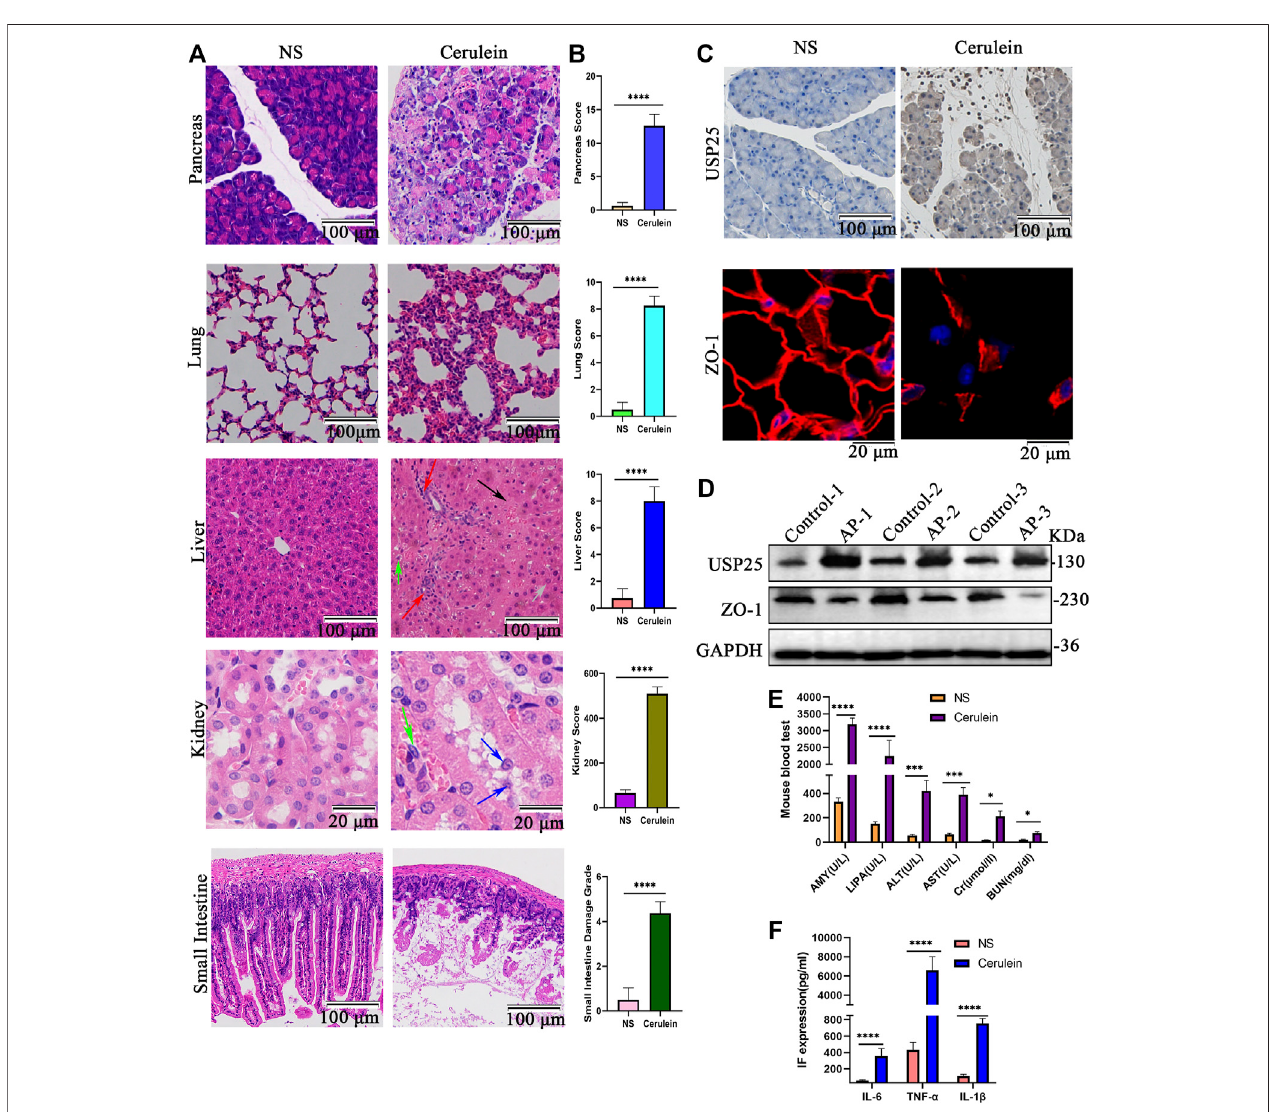
FIGURE 2 | The expression of USP25 is up-regulated in cerulein-induced acute pancreatitis mice and associated with multiple organ injury. Wide type mice were randomlydividedintotwogroups(n (cid:1) 8pergroup),controlgroup:USP25 WT +normalsaline(NS)andAPgroup:USP25 WT +cerulein. (A) H&Estainingofpancreas,lung, liver, kidney, and small intestine in control mice and AP mice (Black arrow: necrosis; red arrow: in fl ammatory cell; green arrow: cytoplasmic vacuolation; grey arrow: edema;bluearrow:detachmentoftubularepithelialcell). (B) Thehistologicalscoresofpancreas,lung,liver,kidney,andsmallintestineincontrolmiceandAPmice. (C) The protein expression level of USP25 and ZO-1 in control and AP mice pancreases were examined by immunohistochemistry and immuno fl uorescence respectively. (D) The USP25 protein level as well as ZO-1 was evaluated by Western blotting. (E) The levels of serum AMY, LIPA, ALT, AST, Cr, BUN were examined by automatic chemical analyzer in control and AP mice. (F) The levels of serum in fl ammatory factor (IF) IL-6, TNF- α , and IL-1 β in control and AP mice were measured by ELISA. * p < 0.05, *** p < 0.001 and **** p < 0.0001 compared with control groups.